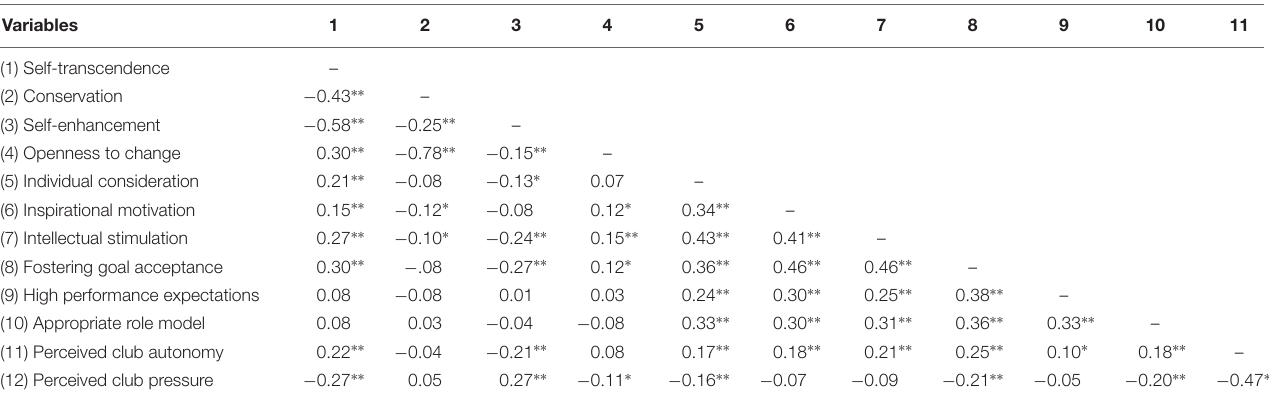
TABLE 5 | Bivariate correlations between value dimensions, transformational leadership behaviors, and perceived club autonomy and pressure ( N = 266 coaches).